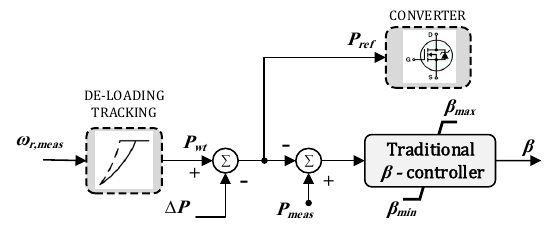
Figure 11. Modified pitch control.